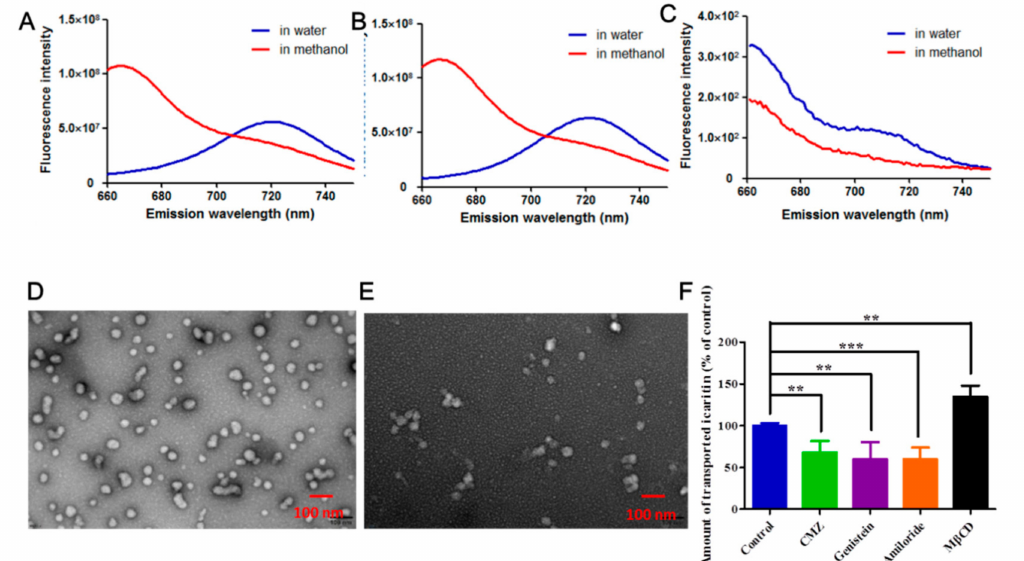
Figure 7. ( A ) Fluorescence emission spectra of FRET micelles at an excitation wavelength of 635 nm. Fluorescence emission spectra of apical medium ( B ) and basolateral medium ( C ) collected after 4 h of transcellular transport of FRET micelles across Caco-2 cell monolayers at an excitation wavelength of 635 nm. TEM images of apical medium ( D ) and basolateral medium ( E ) collected after 4 h of transport of FRET micelles across Caco-2 cell monolayers. ( F ) The influence of various endocytosis inhibitors on the transcytosis of IPMs across Caco-2 cell monolayers ( n = 3). ** p < 0.01 and *** p < 0.001 compared to the control. CMZ, Chlorpromazine hydrochloride; FRET, Forster Resonance Energy Transfer; M β CD, methyl- β -cyclodextrin; TEM, transmission electron